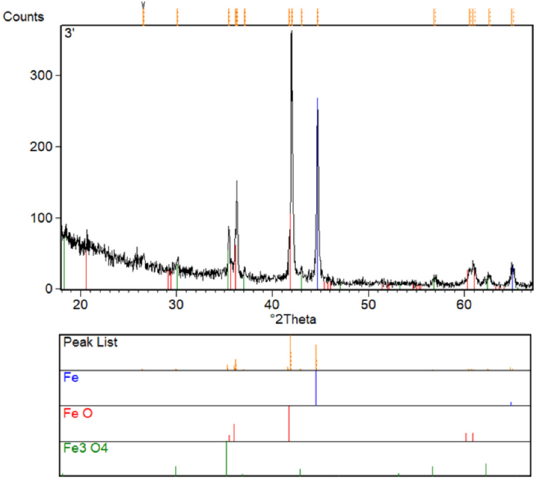
Figure 4. Result of qualitative XRD analysis of examined mill scale. Table 2. Mass fraction of phases identified in examined mill scale.